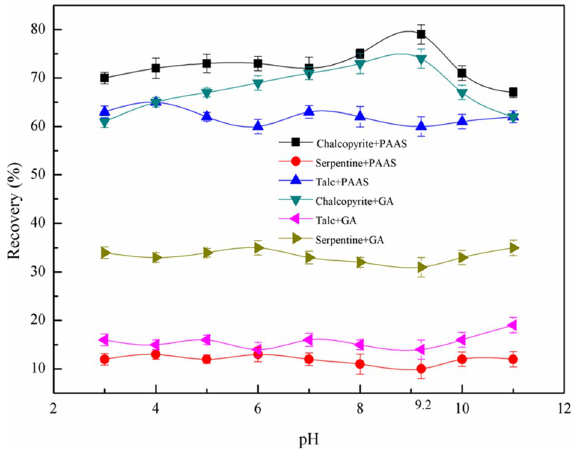
Figure 6. Effect of pH on flotation of minerals, c (PBX) = 80 mg/L, c (PAAS) = 24.7 mg/L, c (GA) = 100